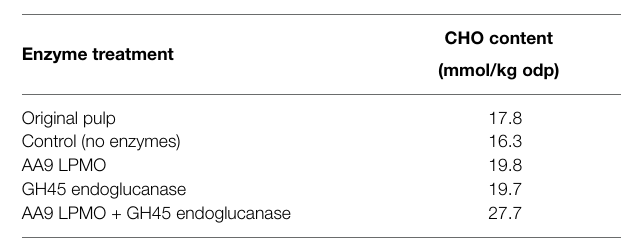
TABLE 5 | Aldehyde group (CHO) content in a viscose-grade dissolving pulp treated with a GH45 endoglucanase and AA9 LPMO, supplemented with 1 mm gallic acid as an electron